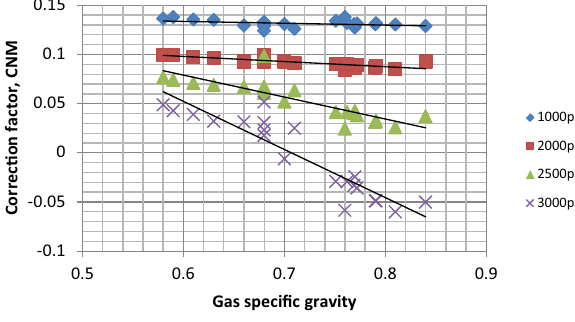
Fig. 2 Calculation of C NM at 120 (cid:3) F and different pressures